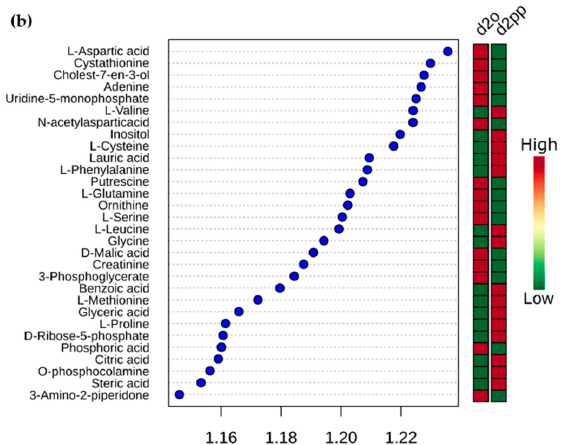
Figure 5. ( a ) Heat map of the metabolic profile in groups d2o and d2pp ( n = 3) after XD14 treatment for two days; ( b ) Top significant metabolites based on variable importance in projection (VIP) score of component 1 in PLS-DA. Colored boxes indicate the relative concentrations of corresponding metabolites.